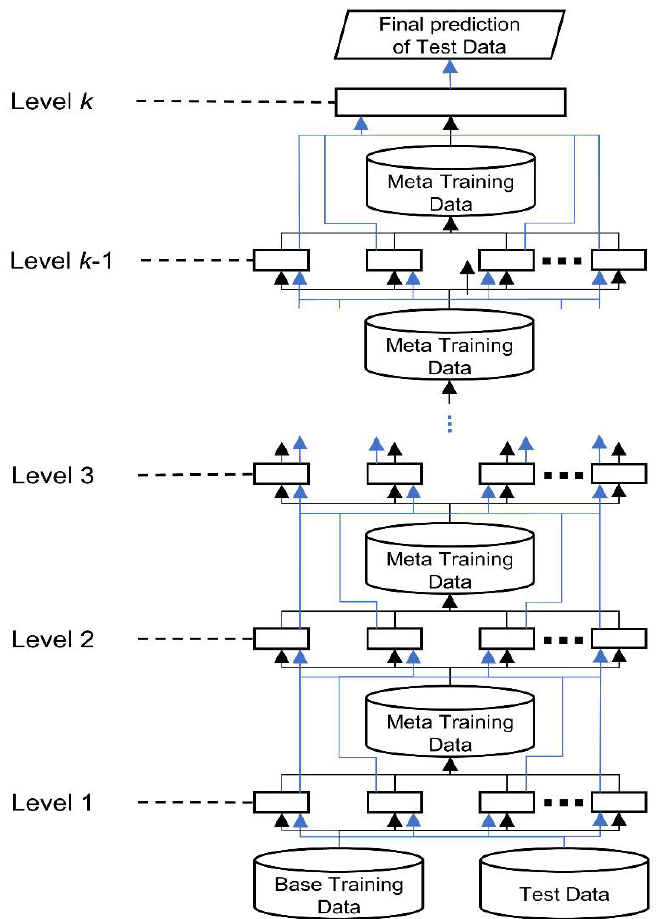
Figure 9. Hierarchical architecture of stacked generalization. The black lines indicate the data flow of training data; the blue lines show the data flow of test data.